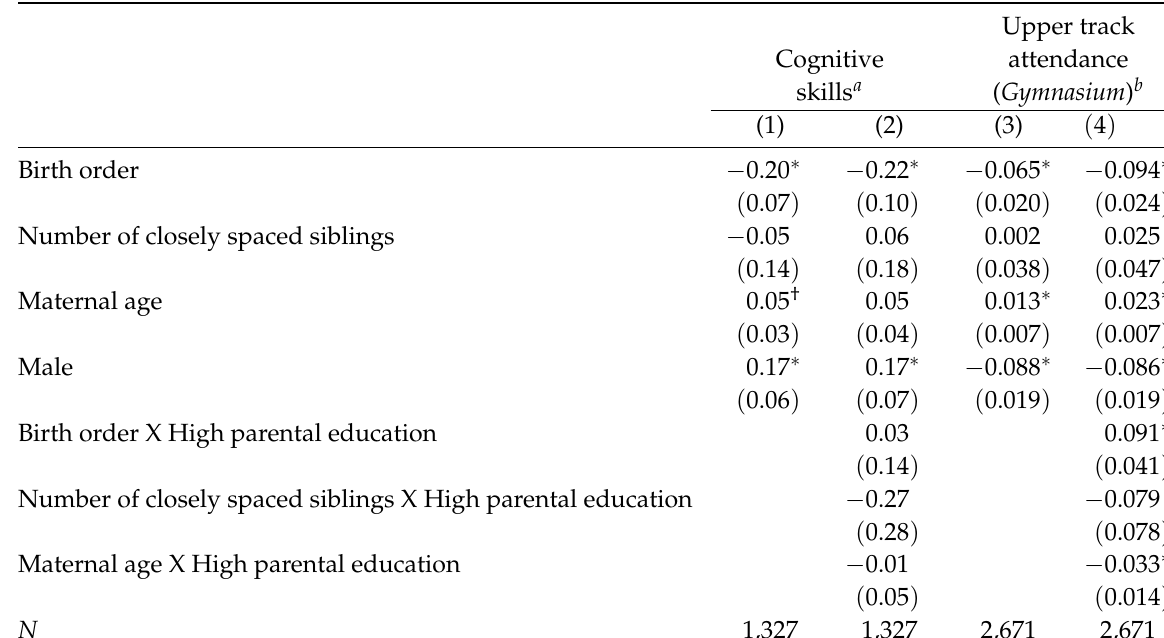
Table 3: Family fixed-effects models of the effects of sibling characteristics on educational